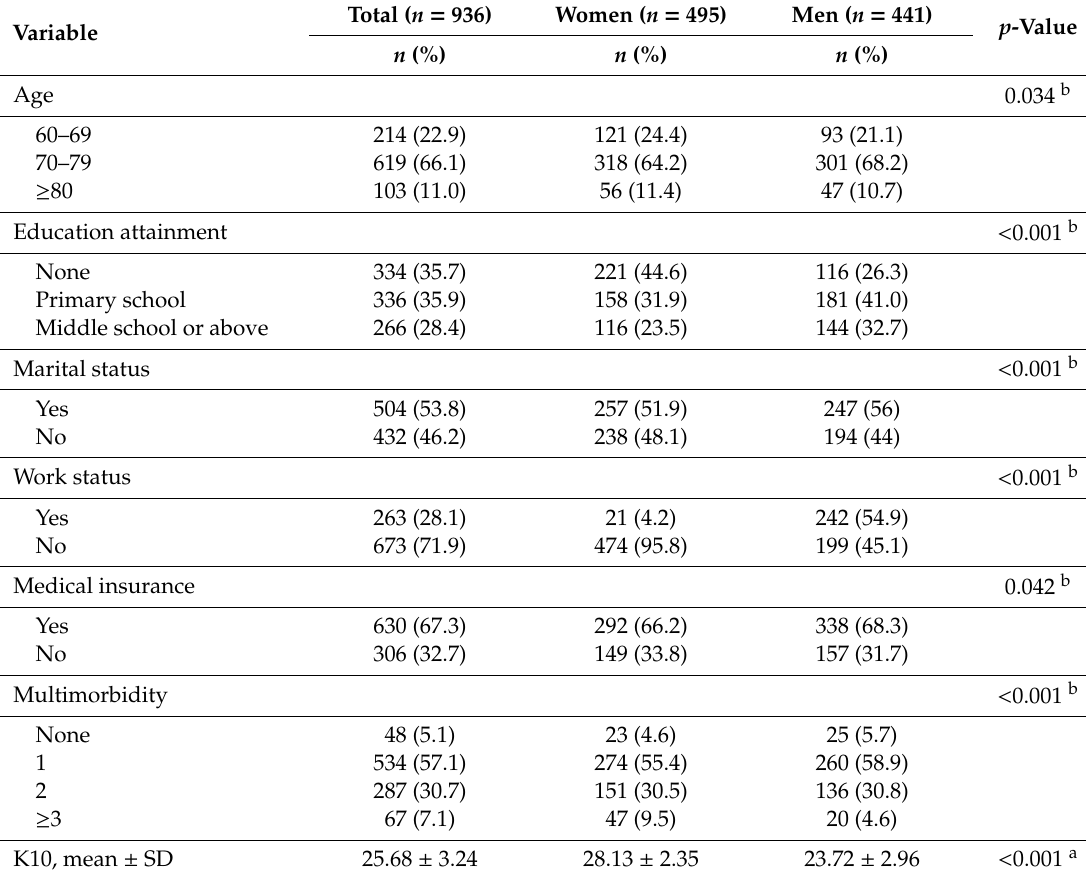
Table 1. Sociodemographic and health-related conditions by gender ( n =